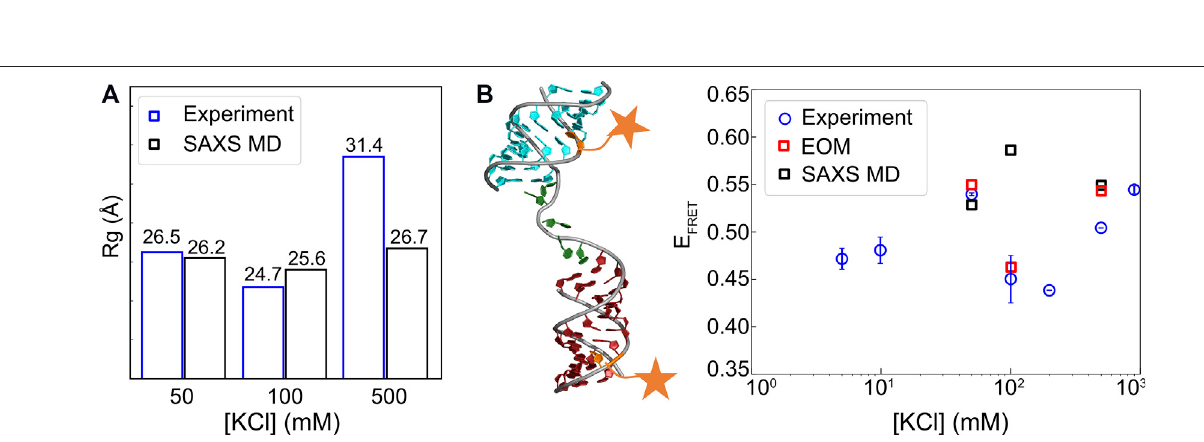
FIGURE 12 | Comparison of radius of gyration (Rg) and ef fi ciency of Förster resonance energy transfer (E FRET ) values from experiment and modeling. (A) Rg from experiment and SAXS-driven MD and (B) FRET ef fi ciencies from simulation and experiment. Fluorescent label sites are brie fl y illustrated by orange stars. R 0 = 60 Å was applied forcomputingthetheoretical E FRET from MDsimulations.Theraw dataand EOManalysiscanbefoundintheworksof Suttonand Pollack(2015)andChenetal. (2019).